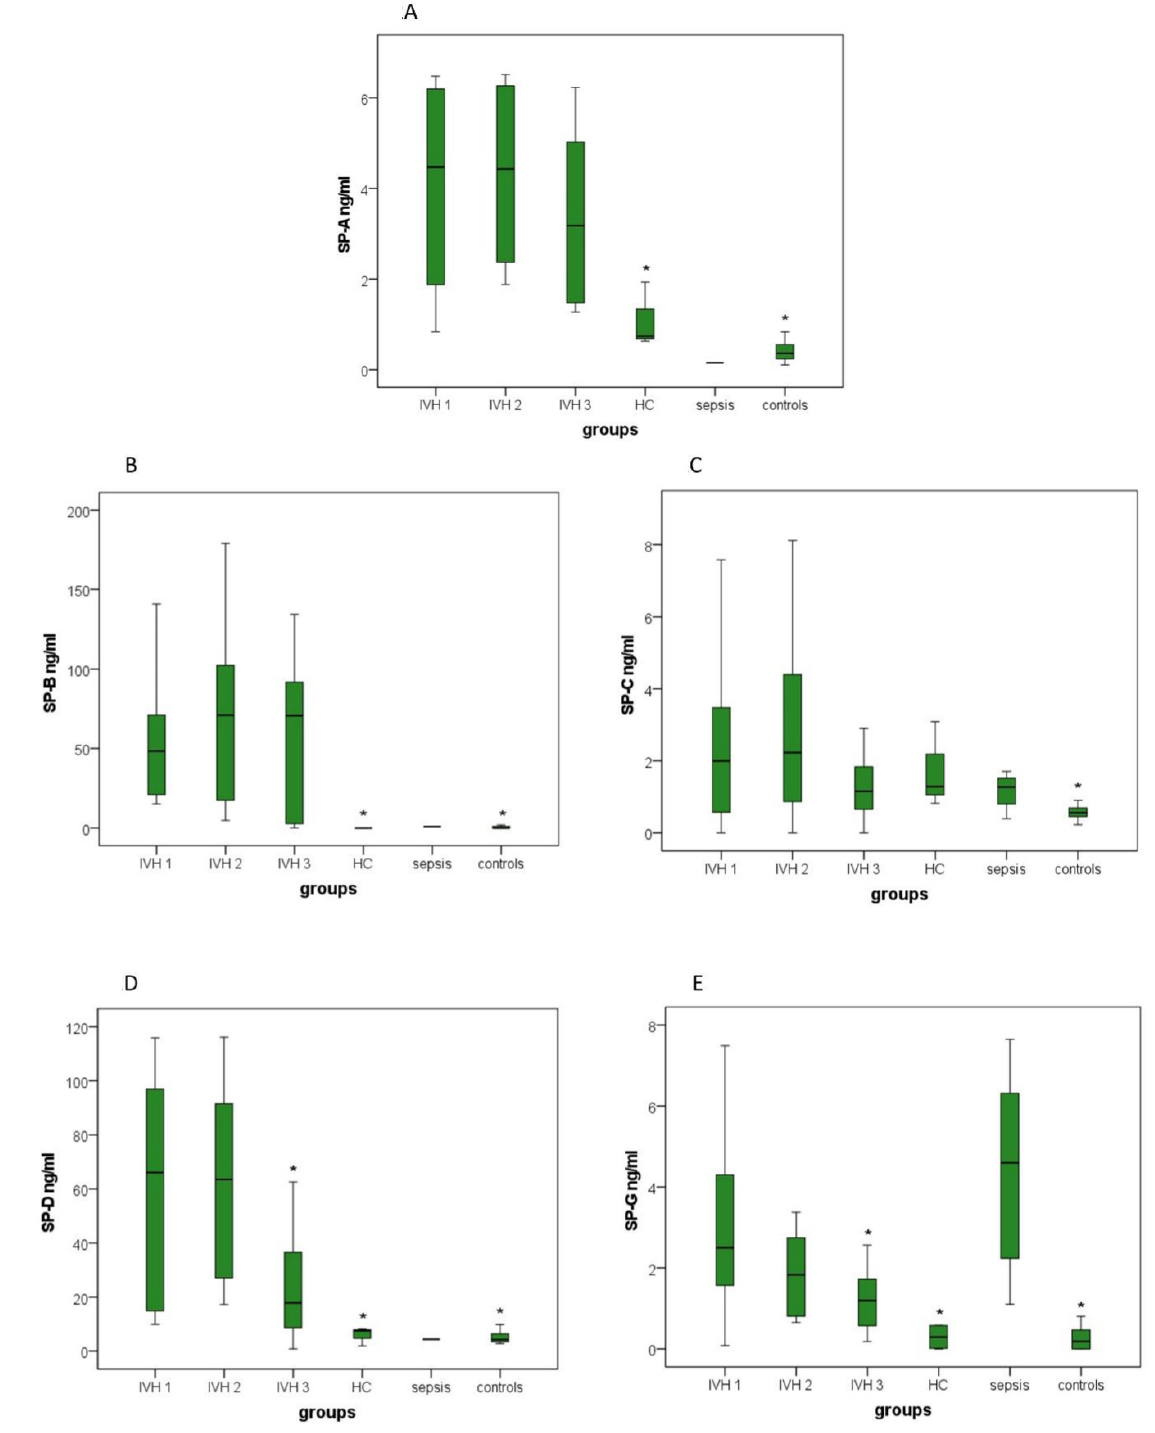
Figure 2. Boxplots: Distribution of surfactant protein levels in the six investigated groups: ( A ) SP-A levels, ( B ) SP-B levels; ( C ) SP-C levels, ( D ) SP-D levels and ( E ) SP-G levels. The sepsis group contained only one specimen in A, B and D. IVH group 1, patients with intraventricular hemorrhage without/before primary intervention; IVH 2, patients with intraventricular hemorrhage at 4–28 days; hydrocephalus patients between 2 days and 14 years old; sepsis, patients aged 2–16 days